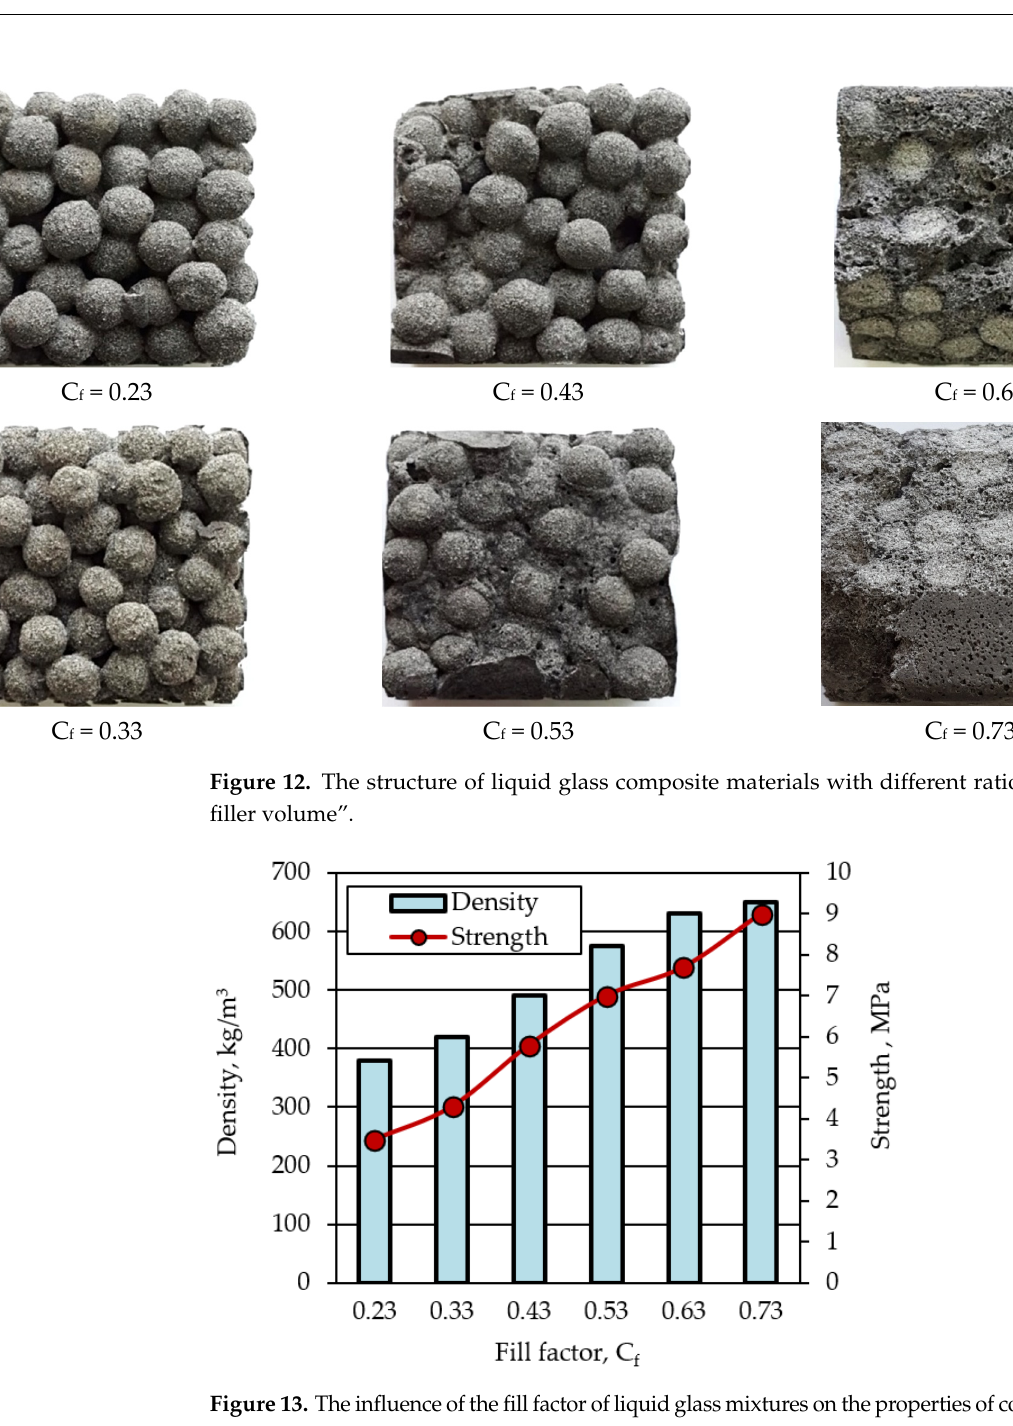
Figure 13. The influence of the fill factor of liquid glass mixtures on the properties of composite materials.